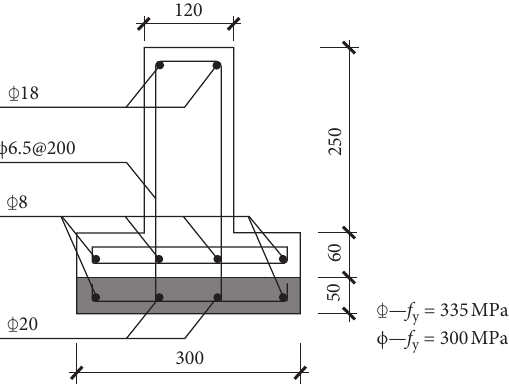
Figure 3: Reinforcement of single-span composite T-shaped beams.